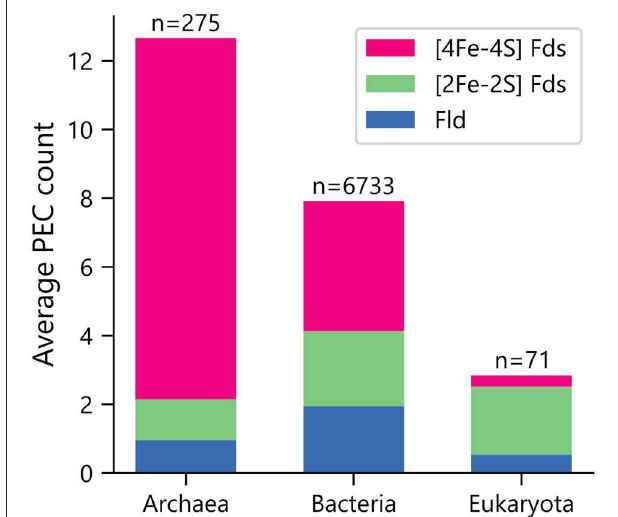
FIGURE 1 | Average PEC gene counts across the domains of life. The average number of PEC genes containing motifs that are characteristic of [4Fe-4S] Fds (red), [2Fe-2S] Fds (green), and Flds (blue) in each domain. The number of genomes analyzed within each domain is shown on top of each bar.